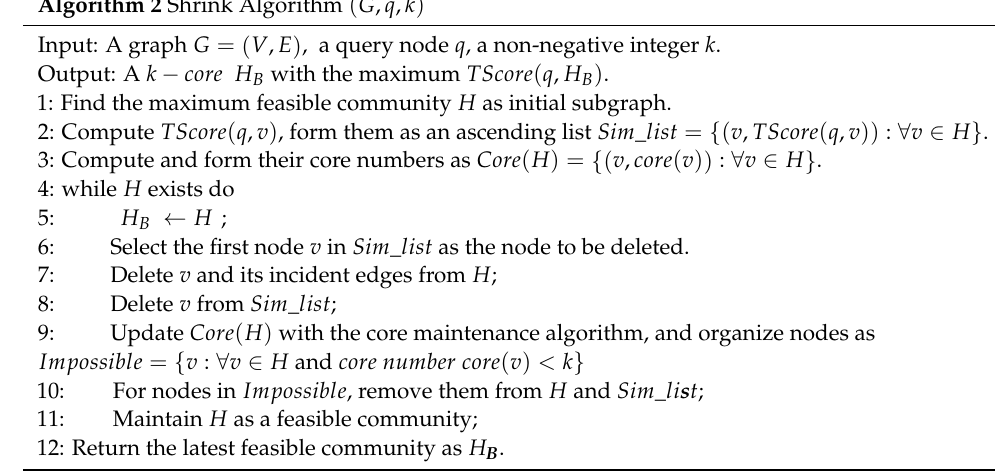
Algorithm 2 Shrink Algorithm ( G , q , k